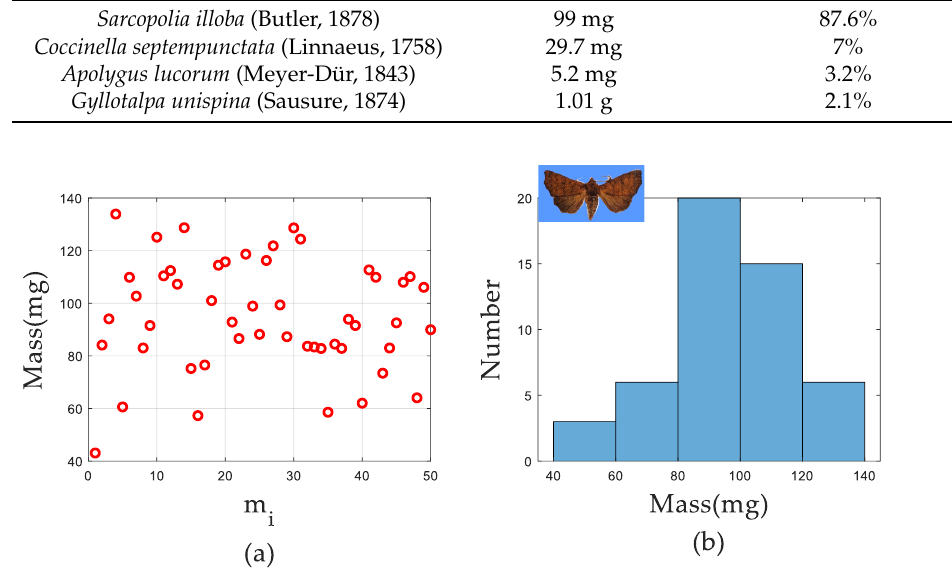
Table 1. Ratios and average mass of the target species among the trapped insects.